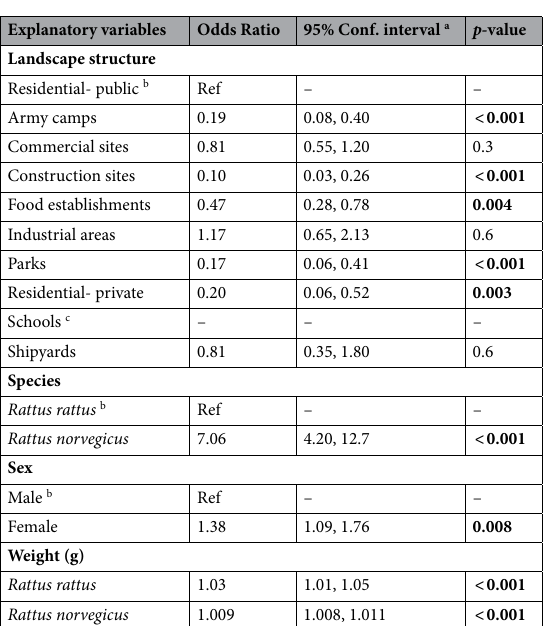
Table 2. Bivariable logistic regression analysis for Leptospira spp. detection in Rattus rattus and Rattus norvegicus . Significant values ( P < 0.05) are shown in bold. a 95% Confidence Interval. b Reference category. c Omitted from the model because no Leptospira infection was detected at this site.